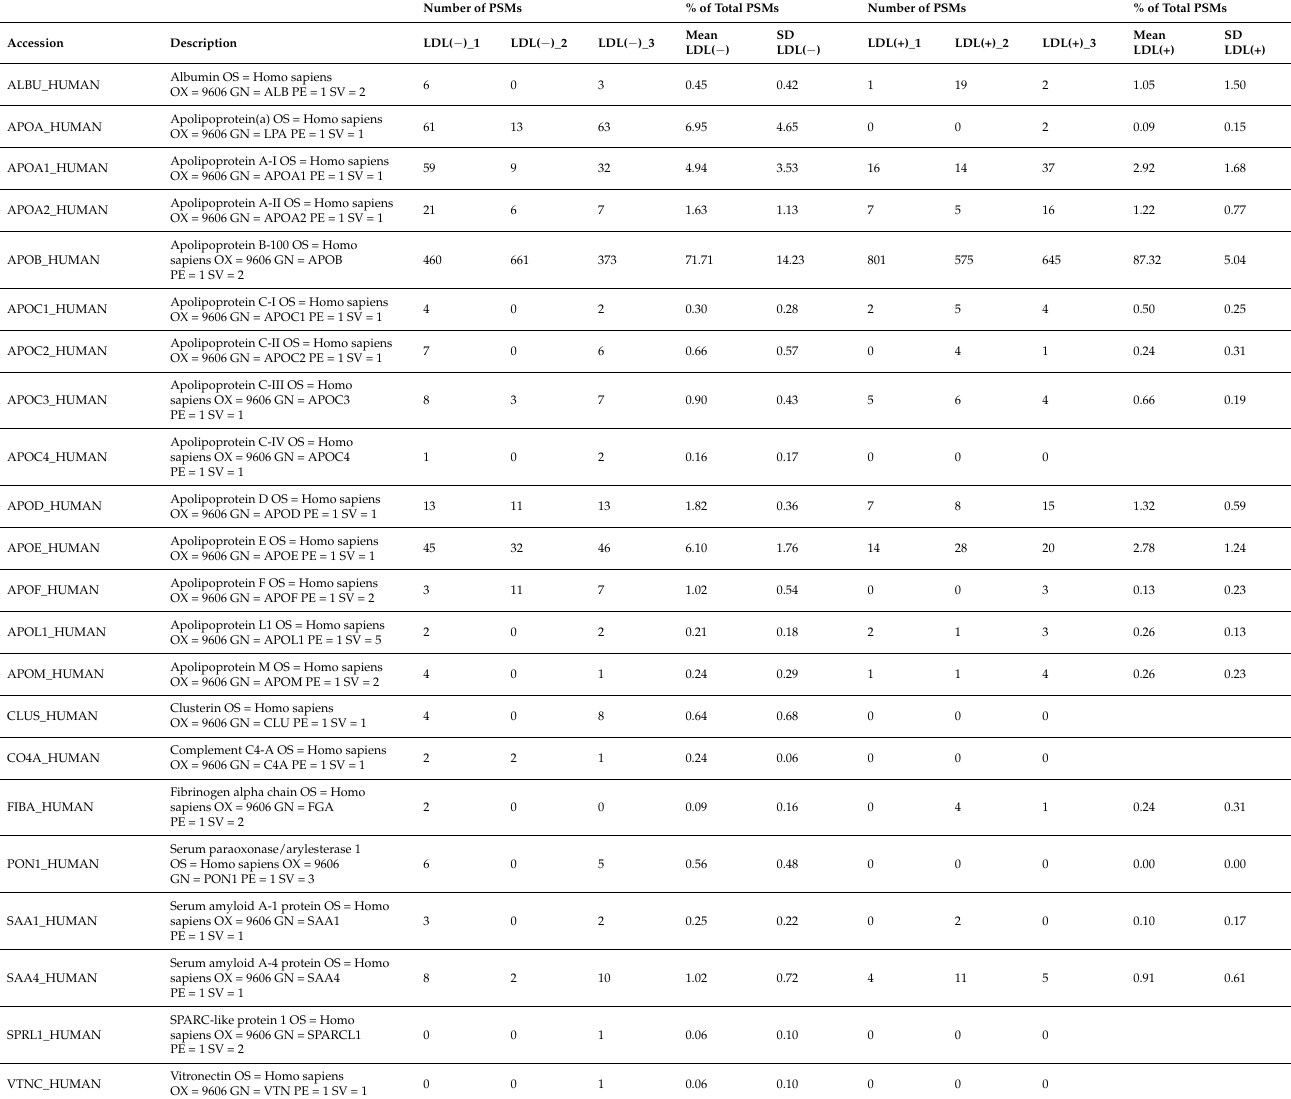
Table 2. Proteomic analysis of LDL